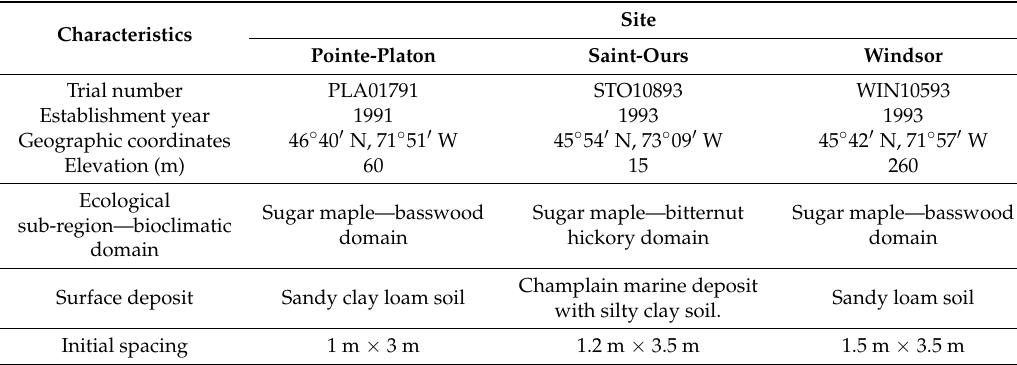
Table 1. Site characteristics of hybrid poplar clonal